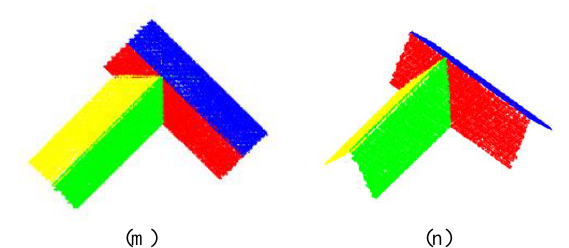
Figure 3. (a) The input dataset, (b) The Gradient image, (c) Ground Truth in 2D view (5 segments), (d) Ground Truth